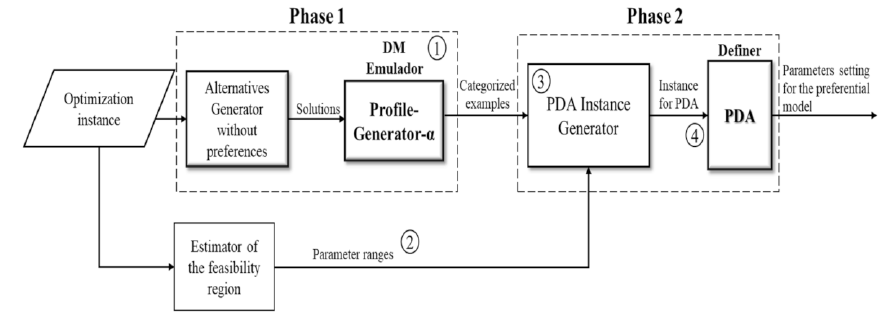
Figure 3. Instance generation process for